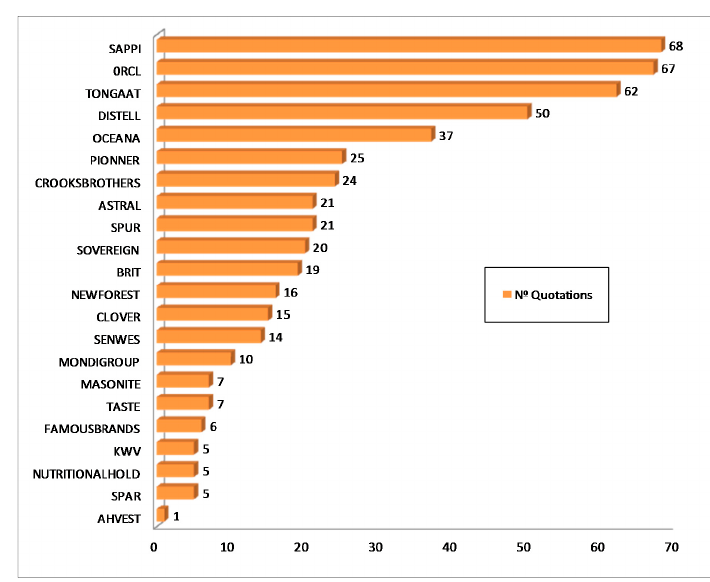
Figure 6. Level of information disclosed related to water issues by company. ( Source: Own work)